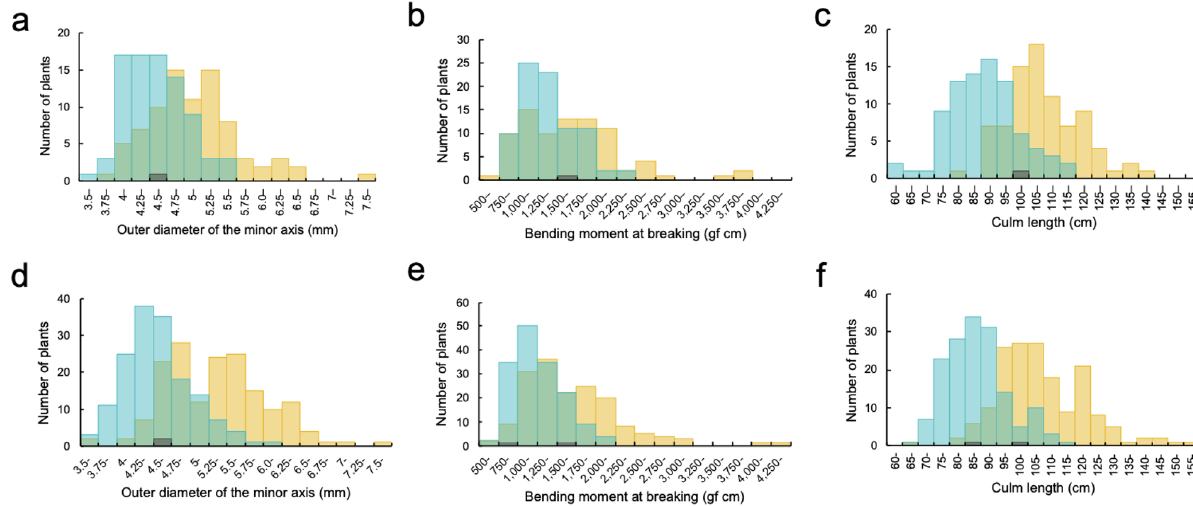
Figure 1. Frequency distribution of lodging resistance-associated traits. Histograms of phenotypic values: ( a ) ODMI in 2018; ( b ) BM in 2018; ( c ) culm length in 2018; ( d ) ODMI in 2019; ( e ) BM in 2019; ( f ) culm length in 2019. The yellow, blue and black bars indicate landraces, breeding varieties and unidentified varieties,